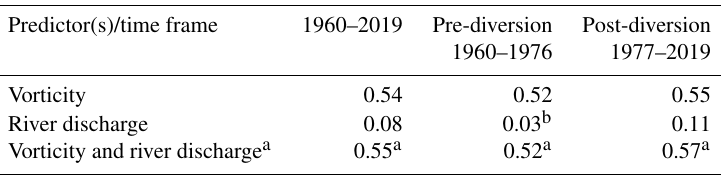
Table 2. Correlations ( R ) of monthly-mean atmospheric vorticity and/or Churchill River discharge against sea-level anomalies in western Hudson Bay for the ice-free period (June–November).